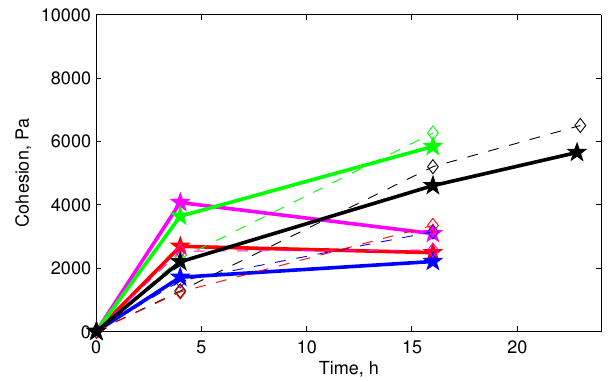
Figure 7. Example of scaling factors, a , and exponents, b , of the power law fit for the cohesion (the filtered population, where marker shapes indicate sensitivity of fit parameters for a “basis” of each fit: the first measurement is at 1min, ♦ , or 30s, F ; c 0 = 400; see also Fig.